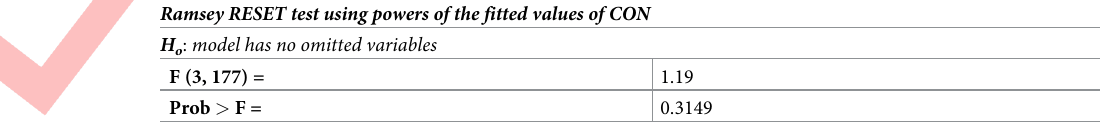
Table 6. Results of Ramsey RESET test. Ramsey RESET test using powers of the fitted values of